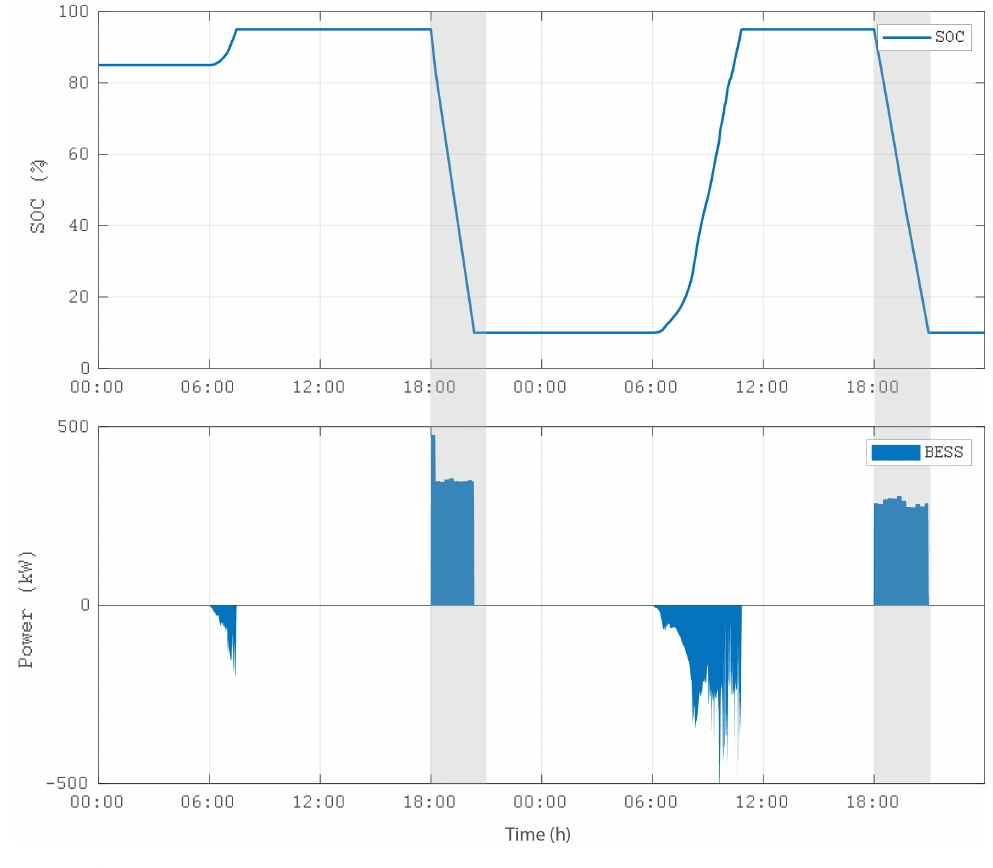
Figure 16. SOC variation and BESS injected/absorbed power for on-grid operation.